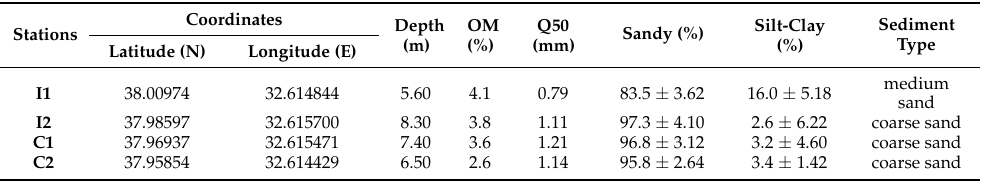
Table 1. Mean environmental characteristics of the four sampling stations during the five campaigns of the March–June